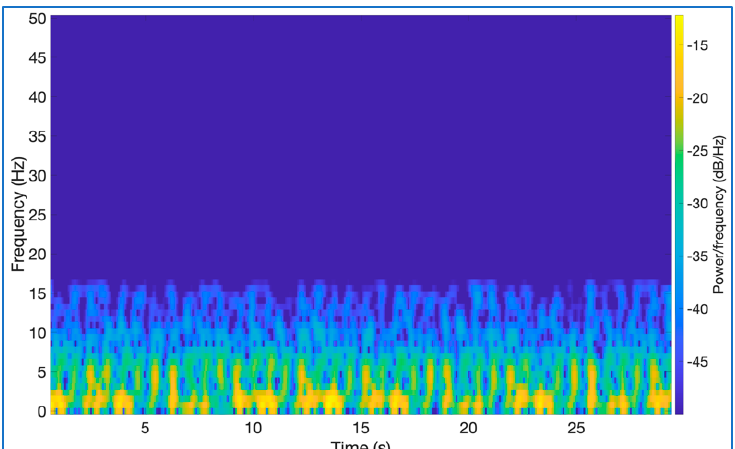
Figure 4. Spectrogram image of a BCG segment (30 s).